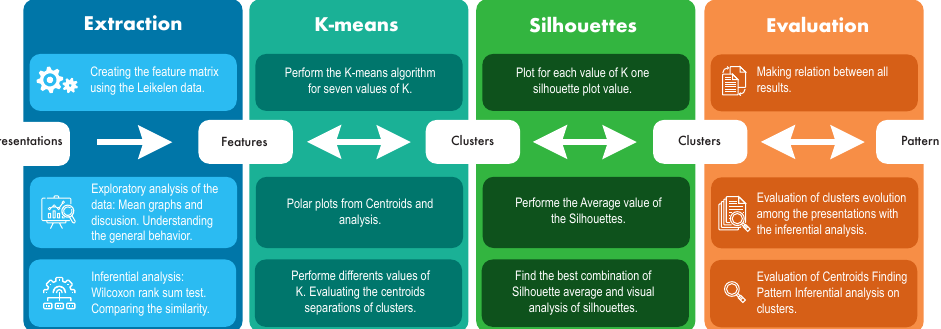
Figure 1. General scheme of the methodology.